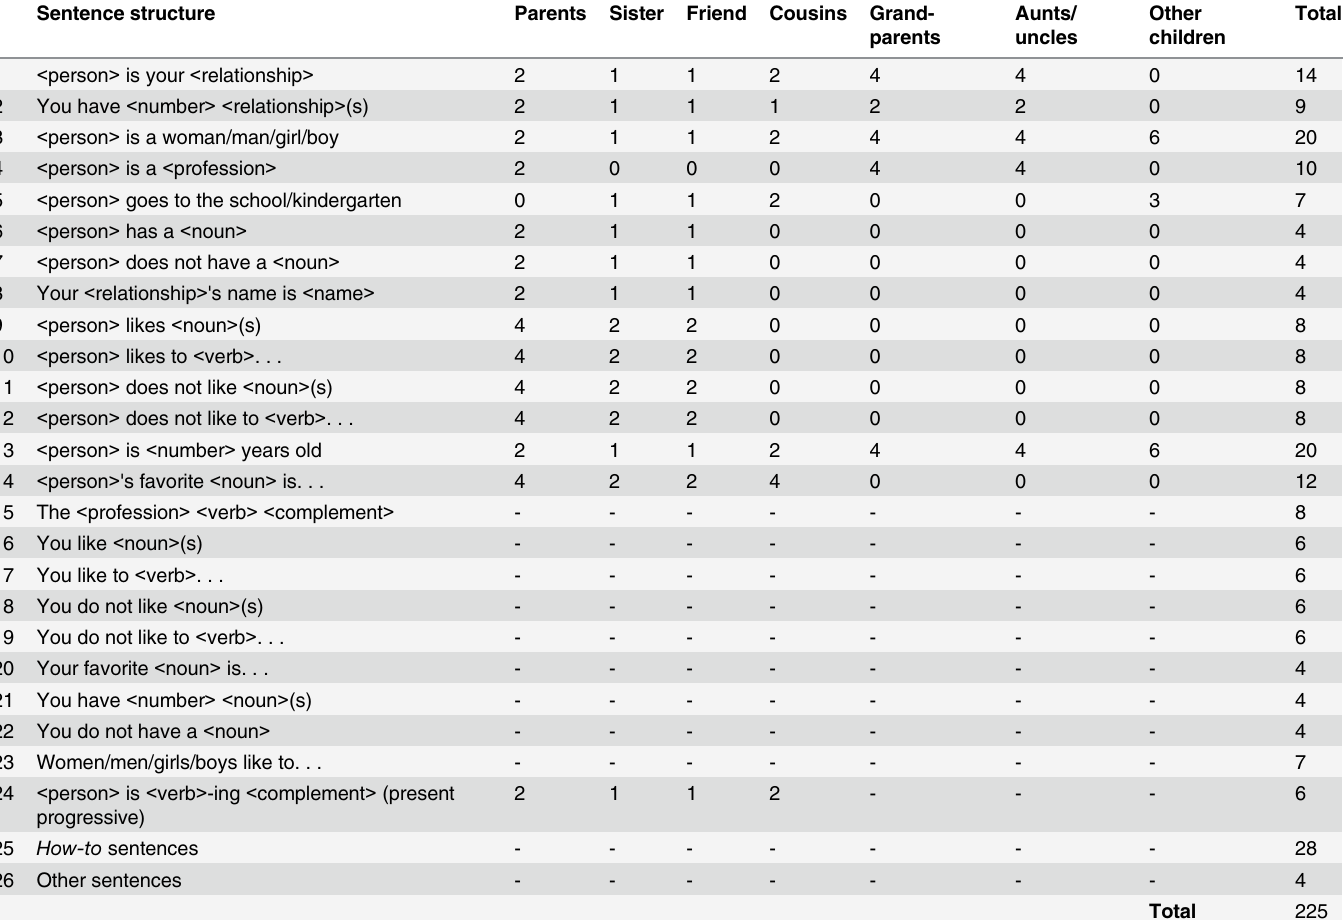
Table 1. Sentences of the people dataset. The social environment described in this dataset includes twenty persons. In the second column, < person > can be “ Mum ” , “ Dad ” , or the name of one of the other eighteen persons, < relationship > can be “ father ” , “ mother ” , “ sister ” , “ friend ” , “ cousin ” , “ Grandma ” , “ Grandpa ”